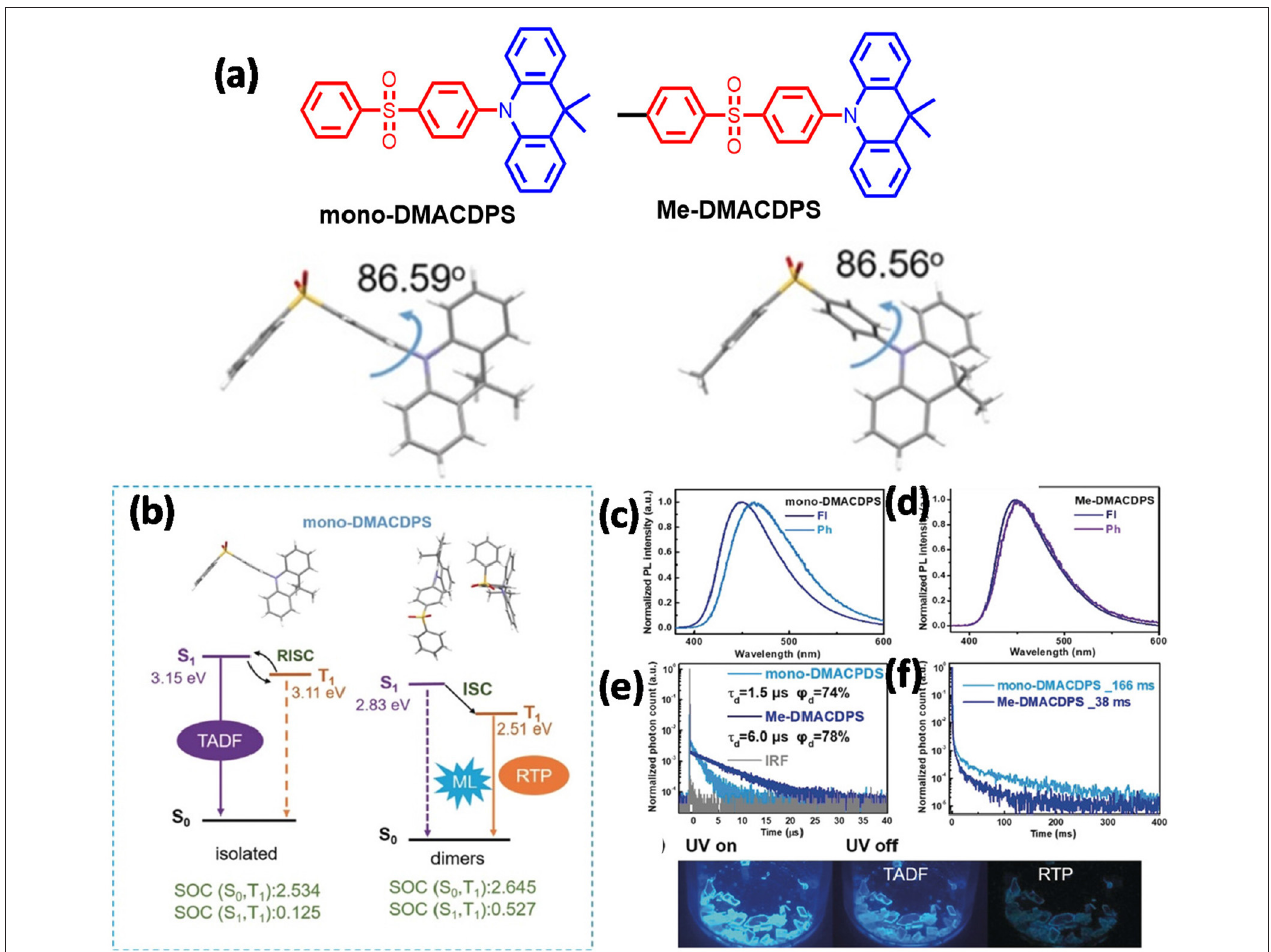
FIGURE 15 | (a) Configurations and XRD structures of the molecules. (b) Energy level diagrams (of the monomer and dimer of mono-DMACDPS). (c,d) PL spectra of studied molecules (at 300K). (e,f) The TRPL spectra of studied molecules. Bottom Crystal images of mono-DMACDPS (UV lamp—on and off). Reproduced with permission from Zhan et al. (2019). Copyright © WILEY-VCH Verlag GmbH andamp; Co. KGaA,